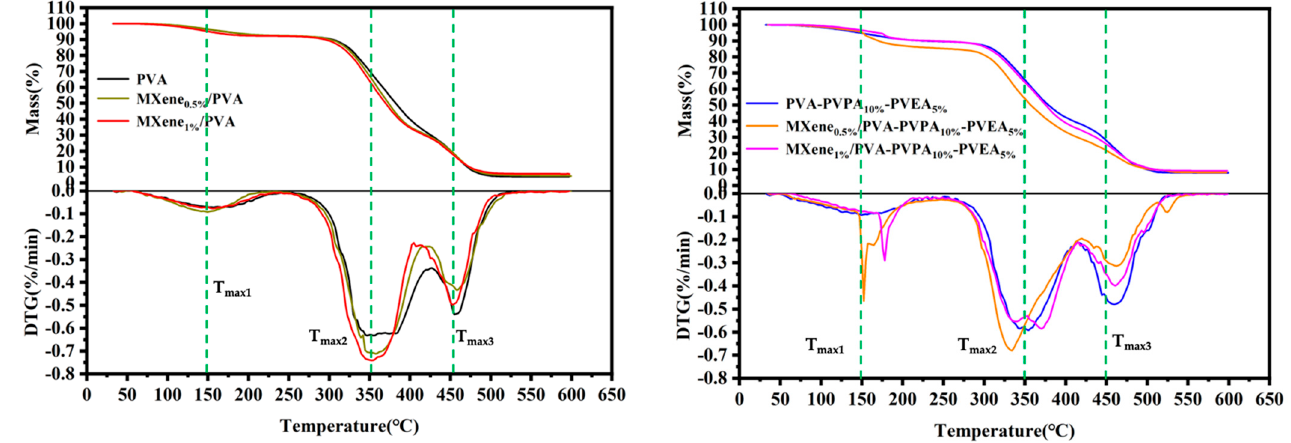
Figure 9. TG and DTG curves of the PVA and MXene/PVA nanocomposites under nitrogen atmosphere. Table 5. TGA data of the PVA and MXene/PVA nanocomposites under nitrogen atmosphere.